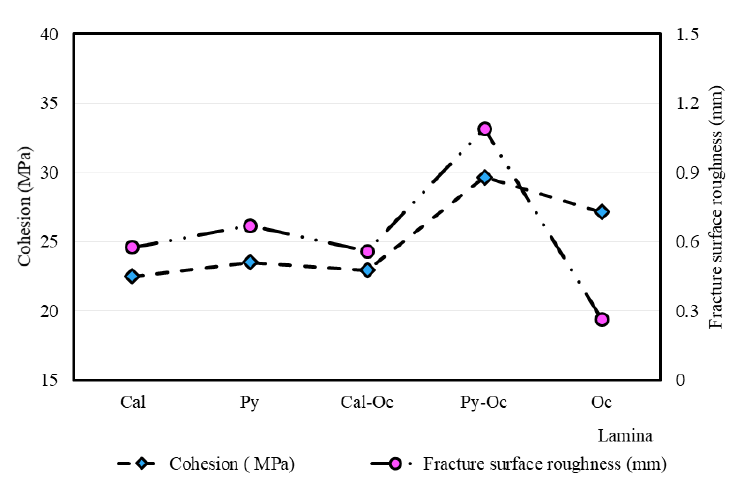
Figure 12. Cohesion and fracture surface roughness variation curve with different lamina.